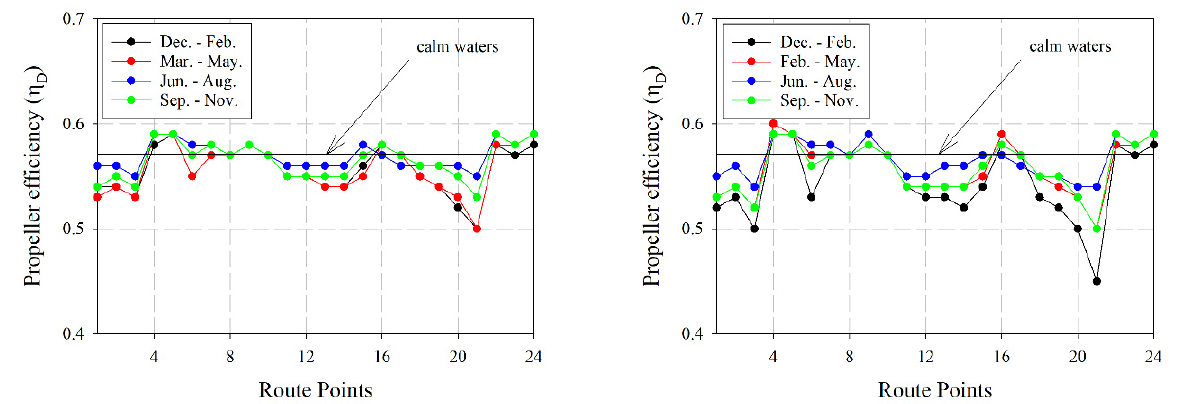
Figure 14. Corrected propeller efficiency according to increase in added resistance for a Froude equal to 0.24. (Left) Load Condition 1. (Right) Load Condition 2. Source: Own elaboration.